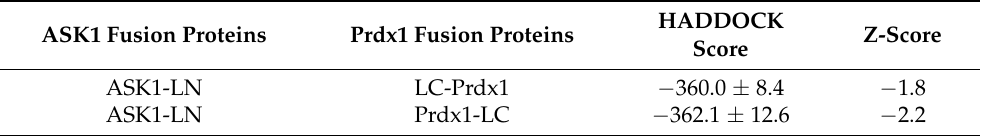
The HADDOCK score and Z-score of each docking are shown. LN: large N-terminal half of mLumin. LC: small C-terminal half of